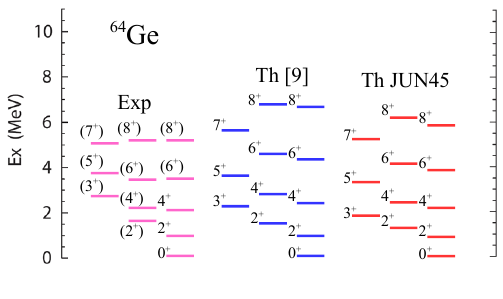
Figure 1. (Color online) Excitation energy spectrum of the g.s. band in 64 Ge obtained in the pf 5 / 2 model space using the JUN45 and the interaction from [9] compared with the experimental re- sults [14].